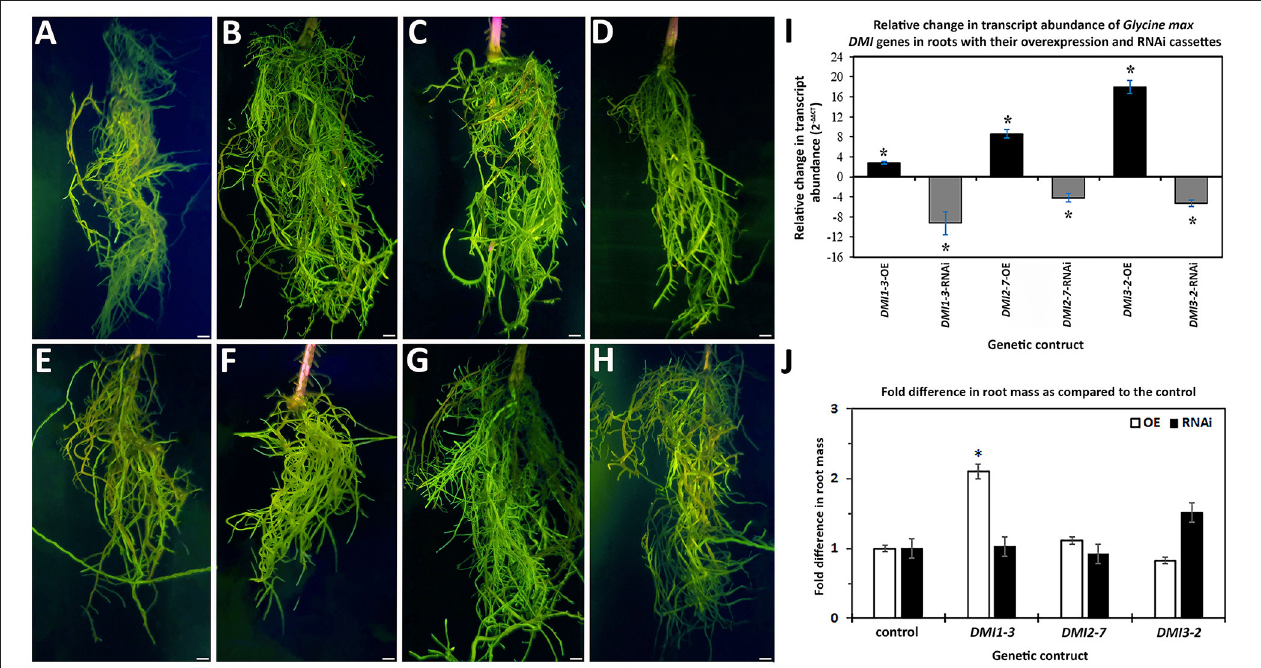
FIGURE 1 | Transgenic roots obtained from chimeric plants having genetically engineered roots and un-engineered shoots that were generated through the K599-mediated genetic transformation procedure. Please refer to Materials and Methods subsections: DMI gene cloning, and G. max genetic transformations, for details. The presented values represent the numbers of plants used in the image generation, and those roots studied in the H. glycines infection analyses. Terminology: overexpression (OE); RNA interference (RNAi); relative transcript abundance (RTA); fold change (FC); probability ( p ) value ( p -value;); female index (FI). (A) pRAP15- ccd B (OE control) ( n = 36); (B) DMI1-3- OE ( n = 30); (C) DMI2- 7-OE ( n = 30); (D) DMI3-2 -OE ( n = 30); (E) pRAP17- ccd B (RNAi control) ( n = 34); (F) DMI1-3- RNAi ( n = 30); (G) DMI2- 7-RNAi ( n = 30); (H) DMI3-2 -RNAi ( n = 30). Bars = 1cm. (I) The expected change in DMI1-3 , DMI2-7 , and DMI3-2 RTA, presented as FC, for the -OE and -RNAi roots, as compared to their pRAP15- ccd B and pRAP17- ccd B overexpression and RNAI controls, respectively, was calculated by 2 − 11 C T to determine FC ( Livak and Schmittgen, 2001; Klink et al., 2021a). The RTA of the candidate defense genes, presented as a FC, in the transgenic roots was compared using the G. max ribosomal protein gene RPS21 (Glyma.15G147700). The RT-qPCR analyses examined 3 experimental replicates (individual root systems) of DMI1-3 , DMI2-7 , and DMI3-2 -OE or -RNAi roots as compared to their pRAP15- ccd B, and pRAP17- ccd B controls, respectively, from each of the 3 biological replicates. Each experimental replicate was run in triplicate using the same RNA. (*), statistical significance of p < 0.05, Student’s t -test ( Yuan et al., 2006). Please refer to Materials and Methods subsection: Real-time quantitative PCR (RT-qPCR), for details. (J) The effect that the expression of the DMI1-3 , DMI2-7 , or DMI3-2 -OE or -RNAi cassettes had on root mass as compared to their respective pRAP15- ccd B or pRAP17- ccd B controls. The statistical significance (*) for the change in root mass was determined using the MWW Rank-Sum Test, p < 0.05 (Mann and Whitney, 1947). Please refer to Materials and Methods subsection: The infection of G. max by H. glycines , cyst extraction, FI calculation, and root mass, for